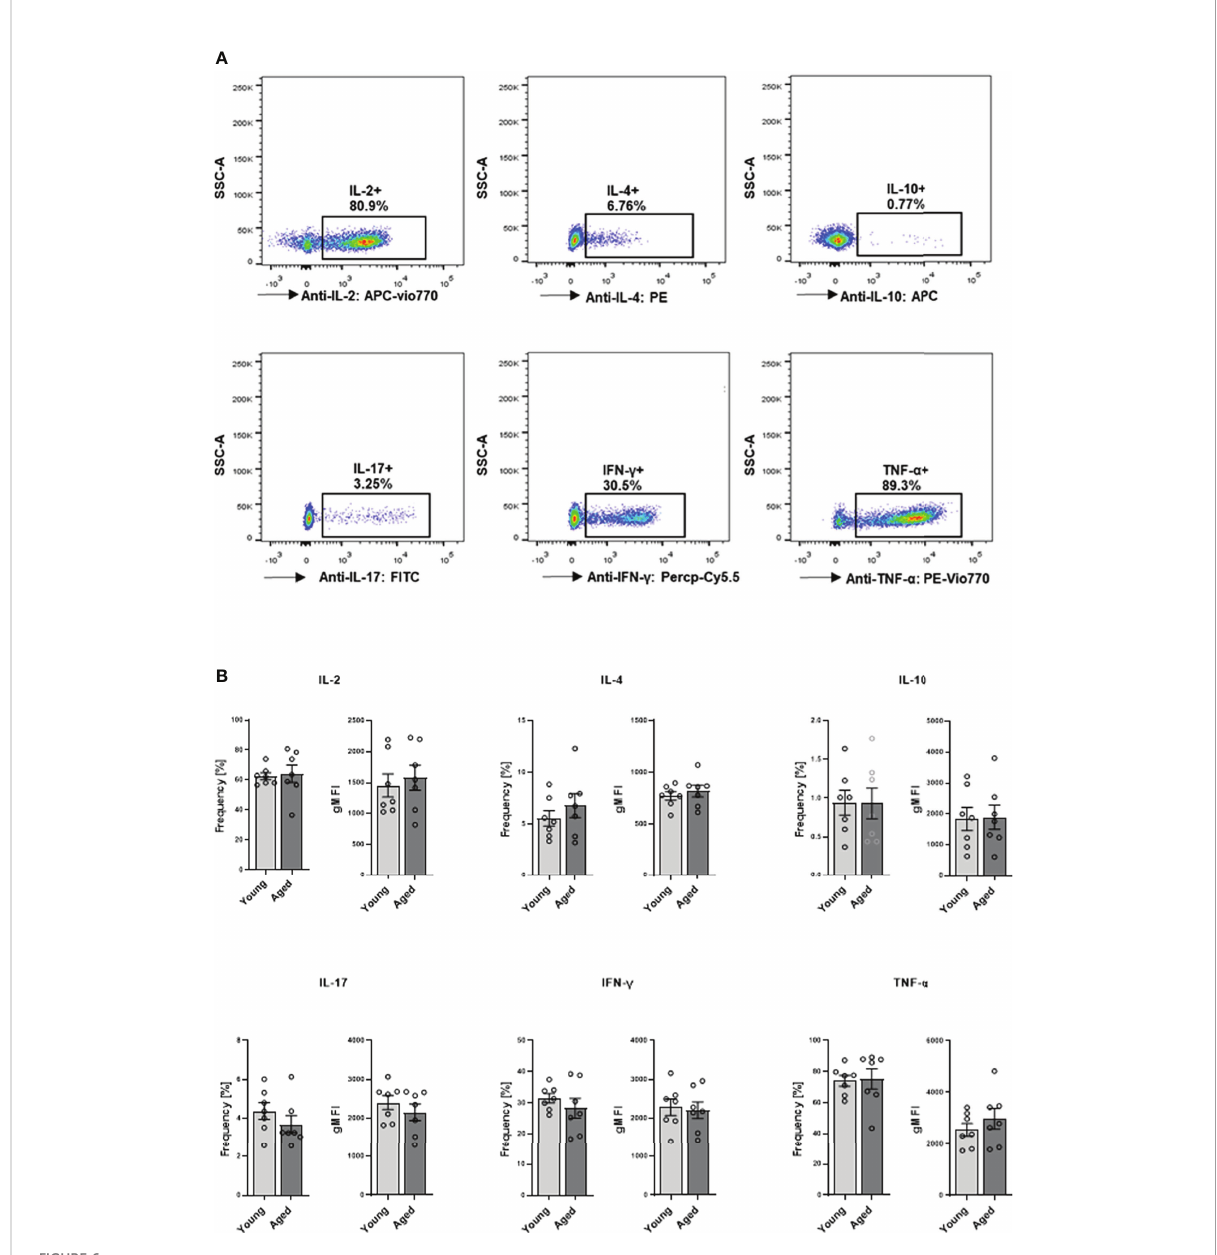
FIGURE 6 Capacity of cytokine production in memory CD4 + T cell. Cells were activated with PMA/ionomycin for 5 h, adding BFA for the last 3 hours for intracellular cytokine expression. (A) Representative example of cytokine expression in memory CD4 + T cells from young and aged donors after stimulation with PMA/ionomycin. (B) Frequencies in % and geometric mean fl uorescence intensity (gMFI) of IL-2, IL-4, IL-10, IL-17, IFN- g , and TNF- a producing memory CD4 + T cells (mean ± SEM; n =